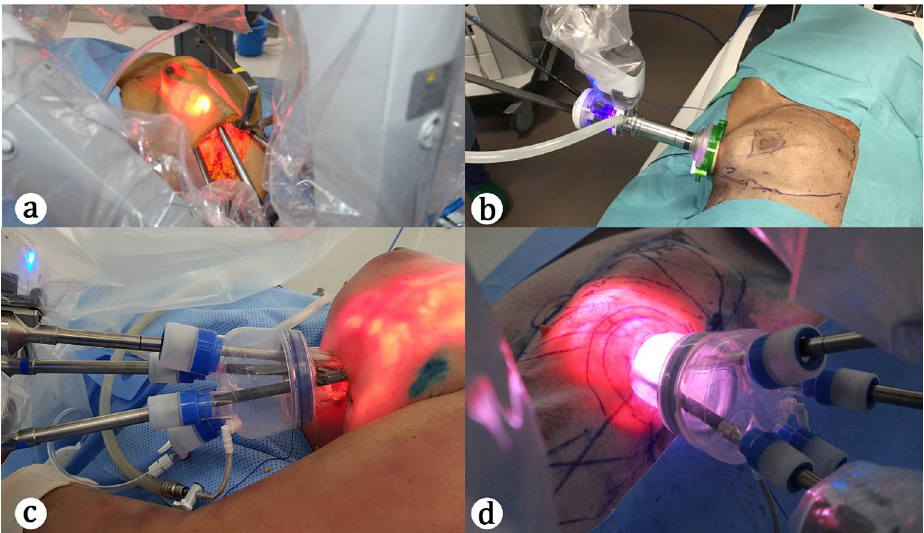
Figure 2. Procedures during various types of surgical skill laboratory training for robotic mastectomy. ( a ) A procedure during the initial development phase of the surgical skill laboratory training for robotic mastectomy using a multiport. ( b ) A procedure during the initial development phase of the surgical skill laboratory training for robotic mastectomy using a single port. ( c ) A procedure during the training phase of the surgical skill laboratory training for robotic mastectomy using a multiport in a cadaveric model. ( d ) A procedure during the training phase of the surgical skill laboratory training for robotic mastectomy using a multiport in a porcine